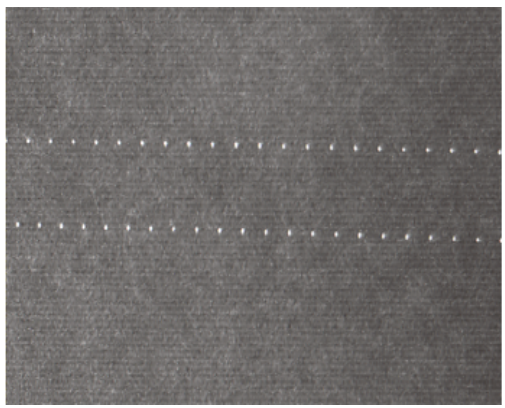
Figure 2: A gray image of perforated tipping